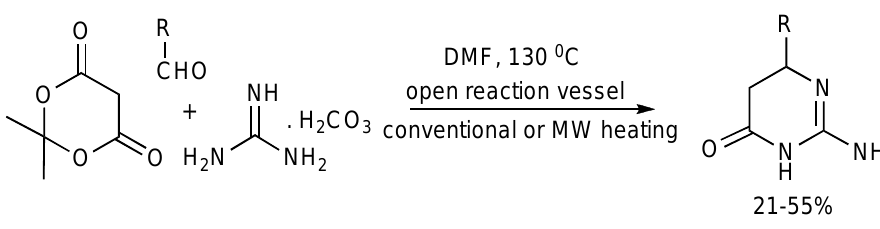
Scheme 6. The Biginelli reaction route to 2-amino-DHPMs.